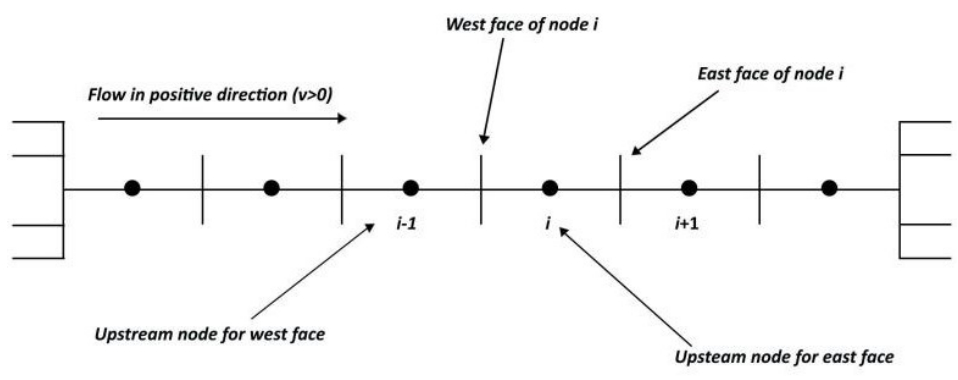
Figure 1. Upstream and downstream nodes for a flow in positive direction.